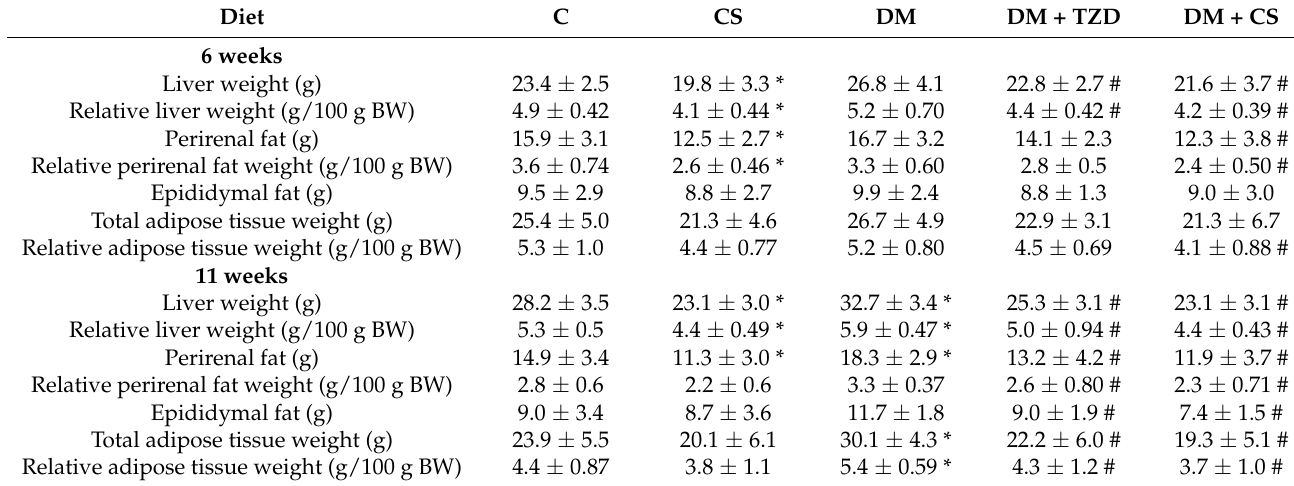
Table 2. The changes of tissue/organ weights in SD rats fed different experimental diets for 6 and 11